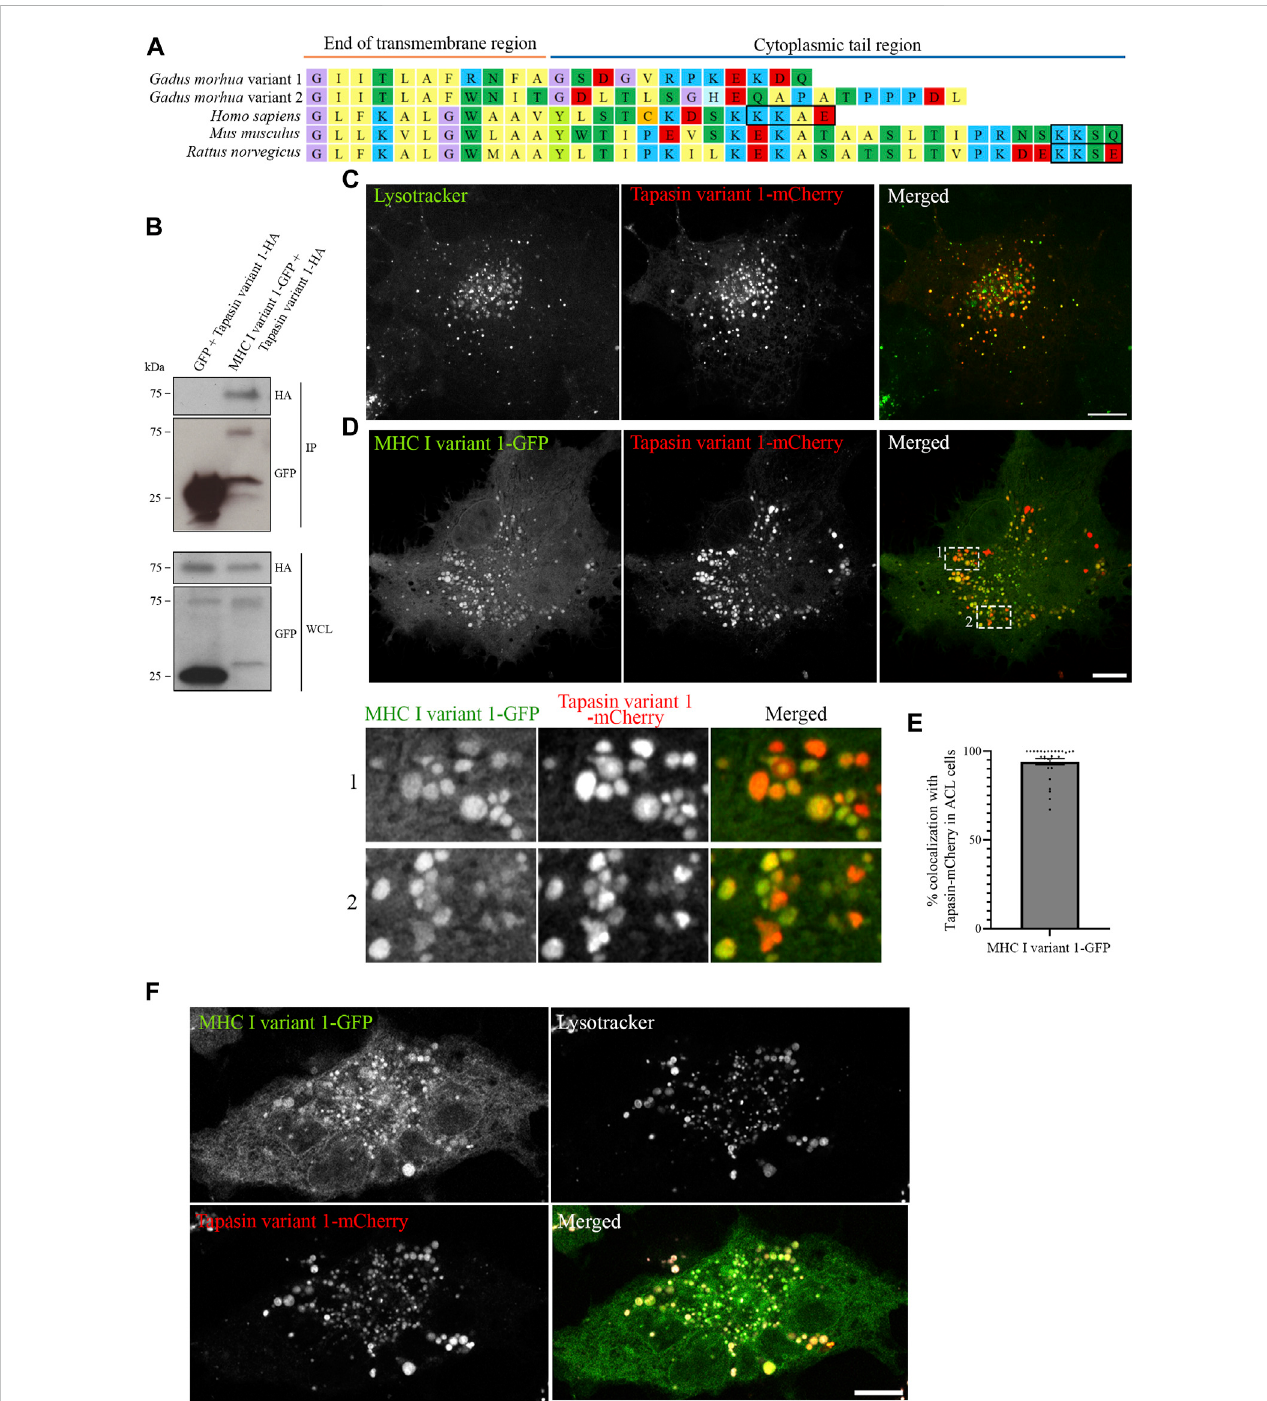
FIGURE 6 Atlantic cod MHC I variant 1 interacts with tapasin and colocalize on endolysosomes. (A) Amino acid sequences of the cytosolic tails of tapasin from Atlantic cod( Gadus morhua ),human ( Homosapiens ),mouse( Mus musculus )and rat( Rattusnorvegicus ).Sequencesweremanually curated and alignedwith MEGA7. ER retention signals (KKXX) are boxed. (B) ACL cells were transiently co-transfected with Tapasin variant 1-HA and either GFP or MHC I variant 1-GFP, lysed and subjected to IP with GFP magnetic agarose beads. Whole-cell lysates (WCL) and immunoprecipitates (IP) were subjected to Western blot analysis using theindicated antibodies. (C) Representative imageof an ACLcell transiently transfected with Atlantic codTapasinvariant 1-mCherry (red). Cells were stained with green lysotracker and imaged using a Zeiss LSM880 Fast AiryScan microscope. Colocalization between green and red channels results in yellowsignalinthemergedpanels.Scalebar:10 μ m. (D) RepresentativeimageofanACLcelltransientlyco-transfected withAtlanticcodMHCIvariant1-GFP (green) and Tapasin variant 1-mCherry (red). The cells were imaged using a Zeiss LSM880 Fast AiryScan microscope. Colocalization between green and red channels results in yellow signal in the merged panels. Scale bar: 10 μ m. Magni fi cation of boxed areas show colocalization between MHC I variant 1-GFP and Tapasin variant 1-mCherry. (E) The graph represents the percentage of colocalization between Atlantic cod MHC I variant 1-GFP and Tapasin variant 1- mCherry. Colocalization was done by object-based analysis using ImageJ software. Values represent the mean ± s.e.m. from at least three independent experiments. n = 28cells. (F) Representativeimageofan ACLcell transiently co-transfectedwithAtlanticcodMHC Ivariant1-GFP (green)andTapasinvariant 1-mCherry (red). The cells were stained with lysotracker deep red (gray) and imaged using aZeissLSM880Fast AiryScan microscope. Colocalization between green and red channels results in yellow signal in the merged panels. Scale bar: 10 μ m.